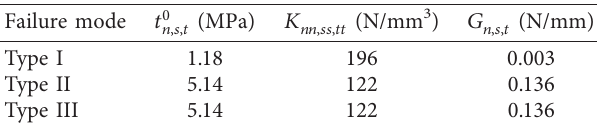
Figure 9: Constitutive model of the cohesive interface element. (a) Bilinear traction-separation constitutive response. (b) Mixed mode behavior [32]. Table 6: Constitutive